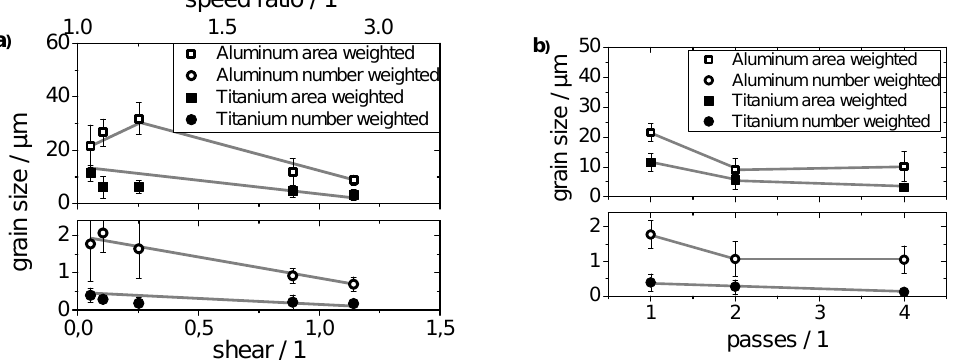
Figure 6. ( a ) Grain size within the Ti and Al layers with different weighting methods being applied: grain area with increasing speed ratio, i.e. , amount of shear and ( b ) evolution of the grain size with increasing number of rolling passes (DSR) with a constant speed ratio of 1:1.